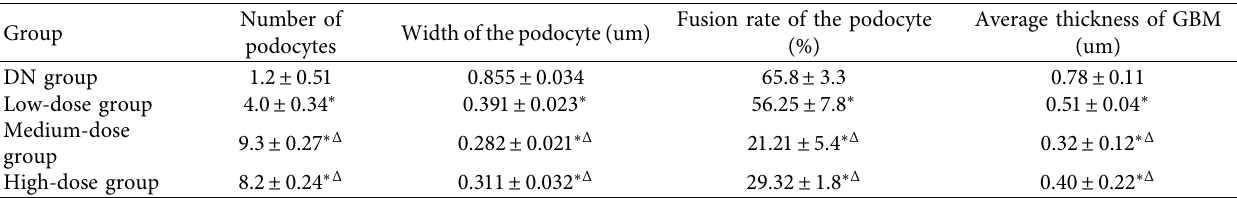
Table 2: Number of podocytes, the width of the podocyte, the fusion rate of the podocyte, and the thickness of the GBM between the models in each group ( x ± s ).